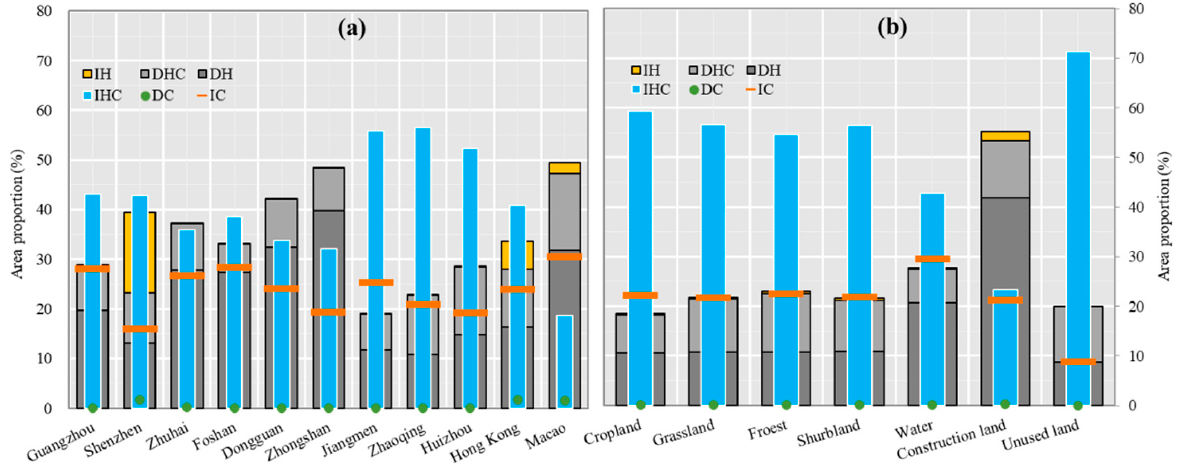
Figure 9. The area of NPP a changes due to different driving forces in the 11 cities ( a ) and land cover types ( b ) from 2000 to 2020. Definitions of the driving forces are given in Figure 2.